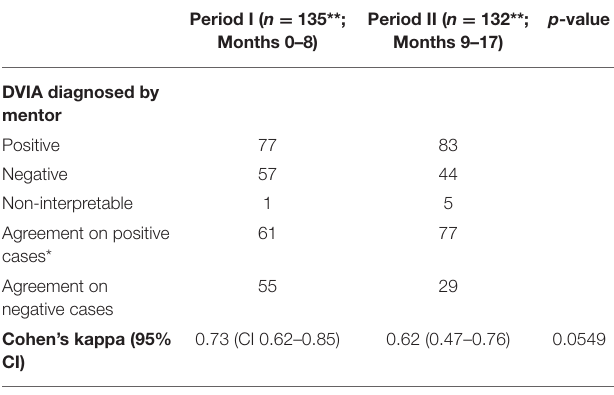
TABLE 4 | Interobserver agreement on DVIA evaluation between HCPs and